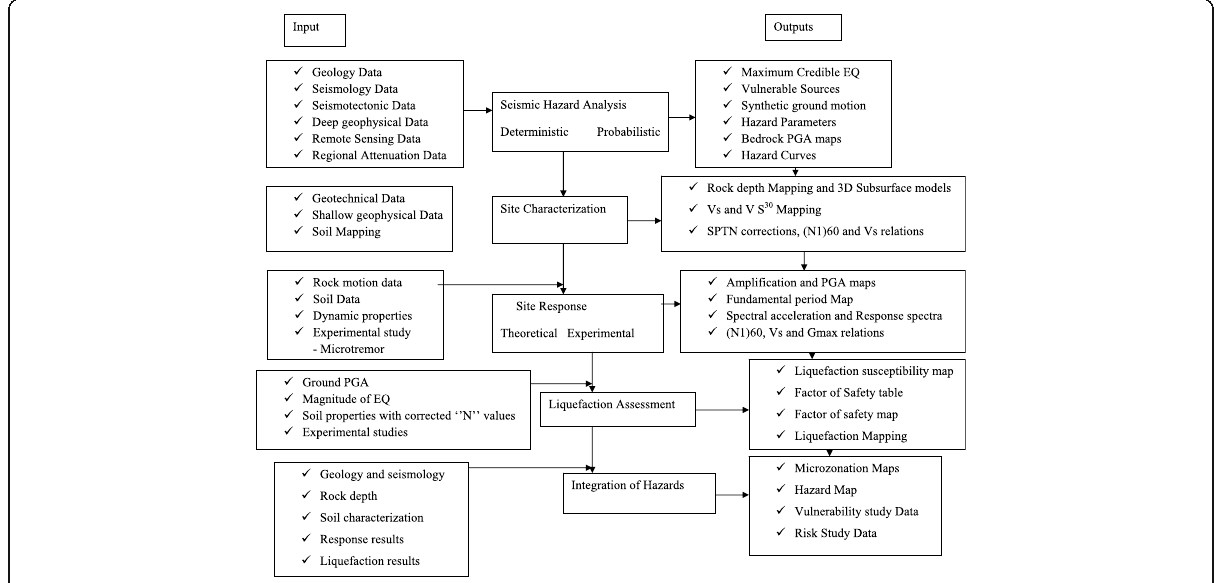
Fig. 11 Steps to be followed for seismic hazard assessment and microzonation studies (Sitharam and Anbazhagan